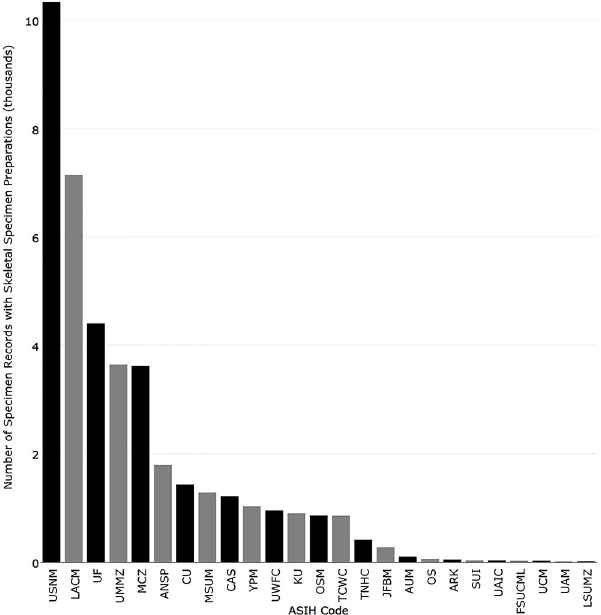
Fig 14. Number of records published in iDigBio with at least one skeletal specimen